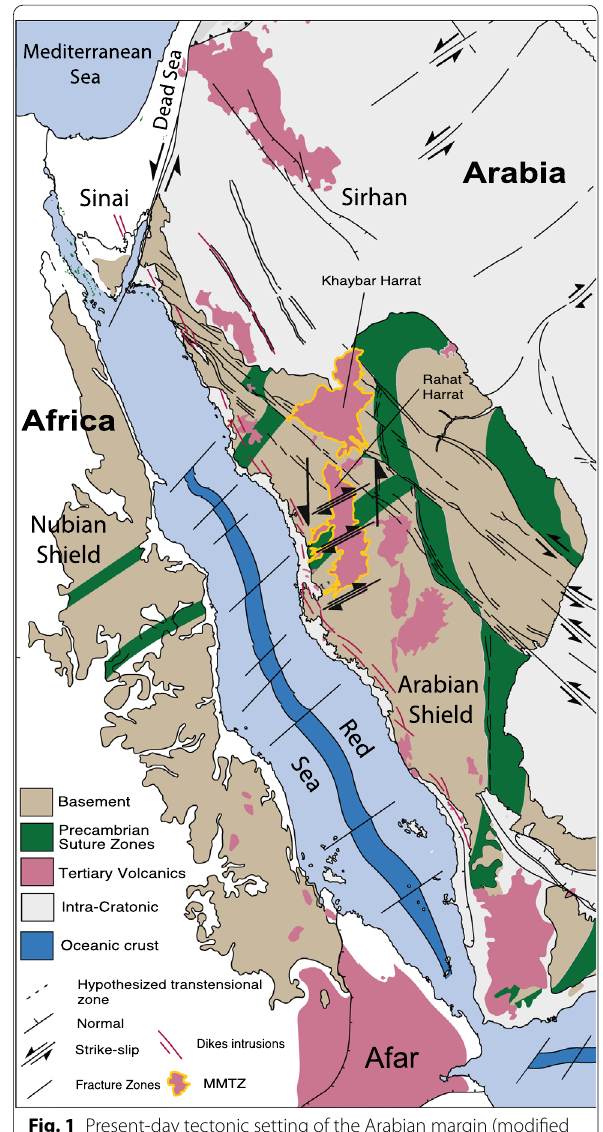
Fig. 1 Present-day tectonic setting of the Arabian margin (modified after Aldaajani et al. (2021a, b)). This map shows the changes extensional style along the Red Sea. The region of diffuse extension, and the MMTZ, which bounds the diffuse grabens and dike intrusions to the south is shown. The MMN volcanics are outlined in dark green. The central Red Sea transforms and curvature region show potential spatial correlation with the MMN volcanics